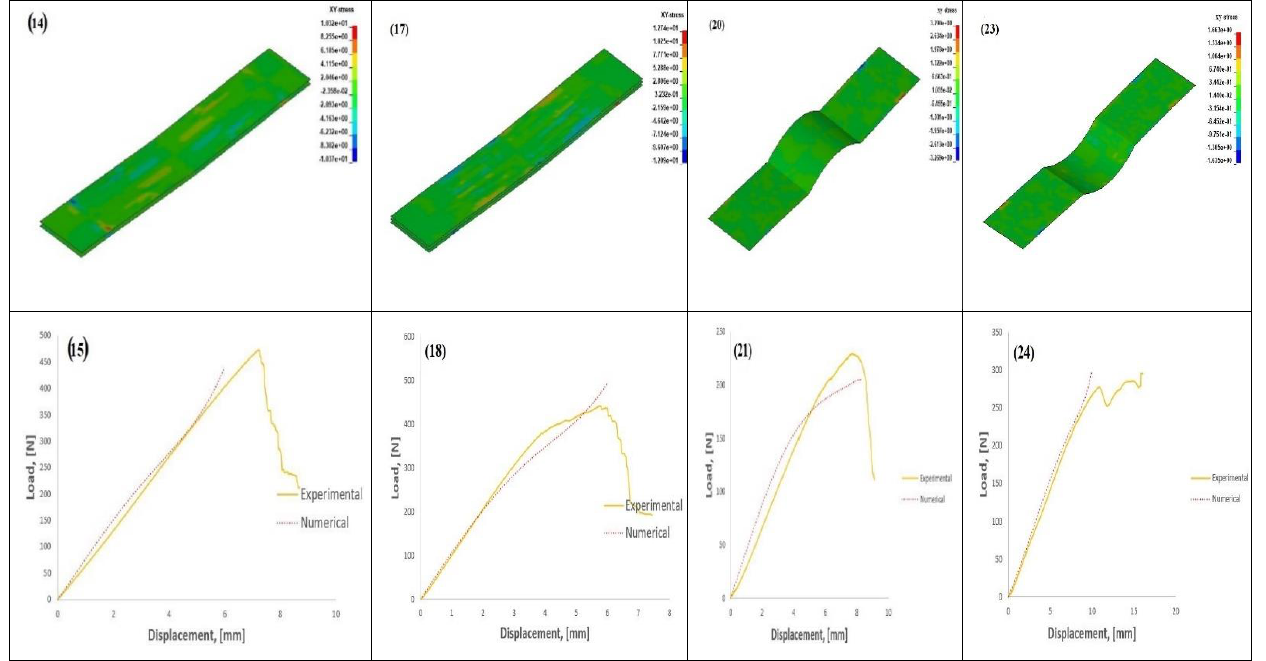
Figure 8. Numerical results (stress fields along the -x and -xydirections, load displacement plots) captured on LS DYNA for all the specimen types studied. ( 1 ) Stress in x-direction for T-1, ( 2 ) Stress in xy-direction for T-1, ( 3 ) Load curve for T-1. ( 4 – 6 ) Stresses and load curve for T-2. ( 7 – 9 ) Stresses and load curve for T-3. ( 10 – 12 ) Stresses and load curve for T-4. ( 13 – 15 ) Stresses and load curve for T-5. ( 16 – 18 ) Stresses and load curve for T-6. ( 19 – 21 ) Stresses and load curve for T-7. ( 22 – 24 ) Stresses and load curve for T-8. Table 4. Comparison between experimental and numerical loads obtained in flexure.